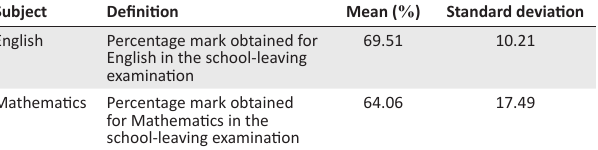
TABLE 2: Performance measures for English and Mathematics over the period 2004–2012.